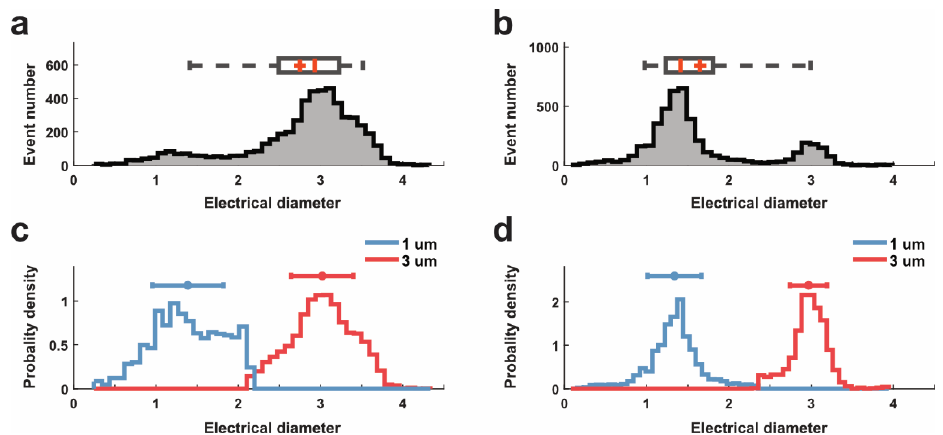
Figure 3. Electrical diameter of polystyrene beads when using different electrode spans for measurement. ( a , b ) Distribution of electrical diameter signals of detected beads in suspension when measuring with ( a ) 5 µm and ( b ) 1 µm electrode span. ( c , d ) The discrimination of two sizes of beads using the single-peak Gaussian model, based on their electrical diameters obtained with ( a ) 5 µm and ( b ) 1 µm electrode span. 1 µm beads were labelled in blue, and 3 µm beads were labelled in red.